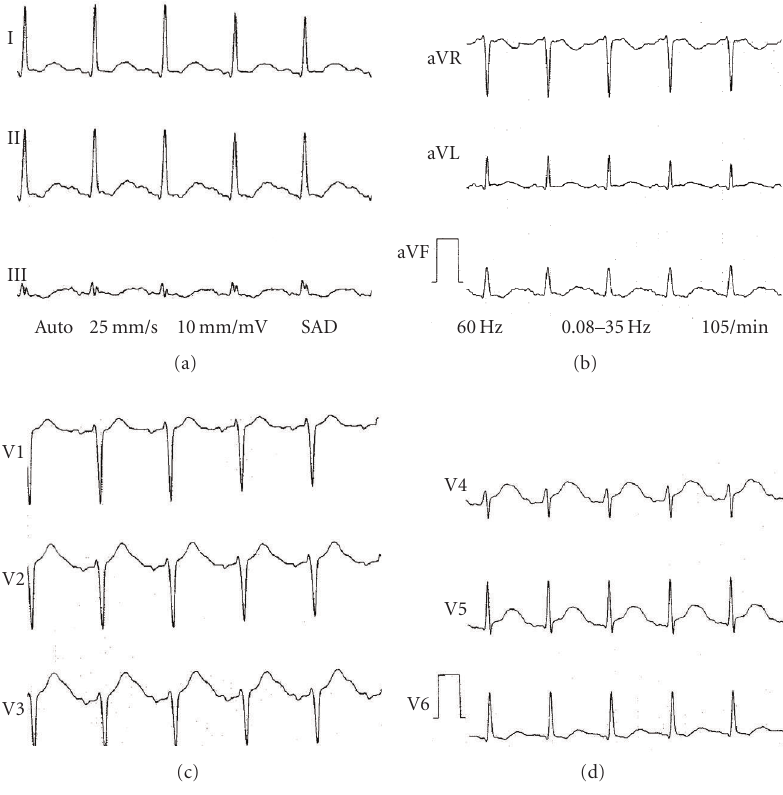
Figure 3: ECG in sinus rhythm demonstrating QT interval